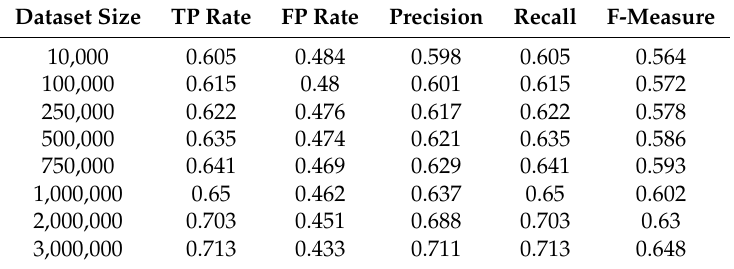
Table 4. Classification of AdaBoost for different dataset